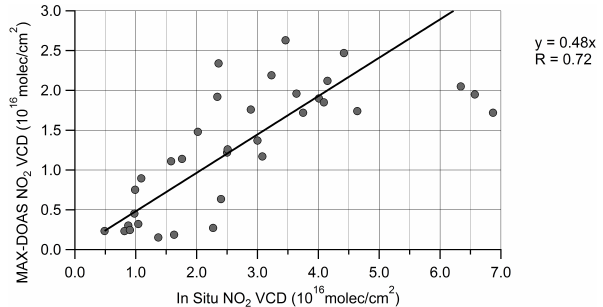
Fig. 6. Linear regression of MAX-DOAS versus in situ tropospheric NO 2 VCD.